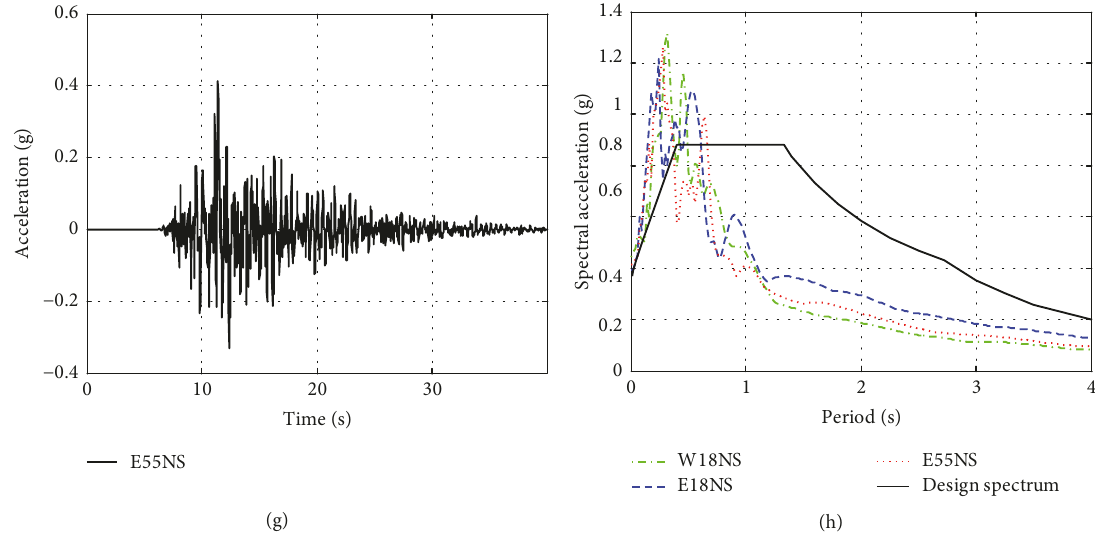
Figure 4: Time history of acceleration: (a) W18EW, (b) E18EW, (c) E55EW, (d) response spectrum in the EW direction, (e) W18NS, (f)E18 NS, (g) E55 NS, and (h) response spectrum in the EW direction.